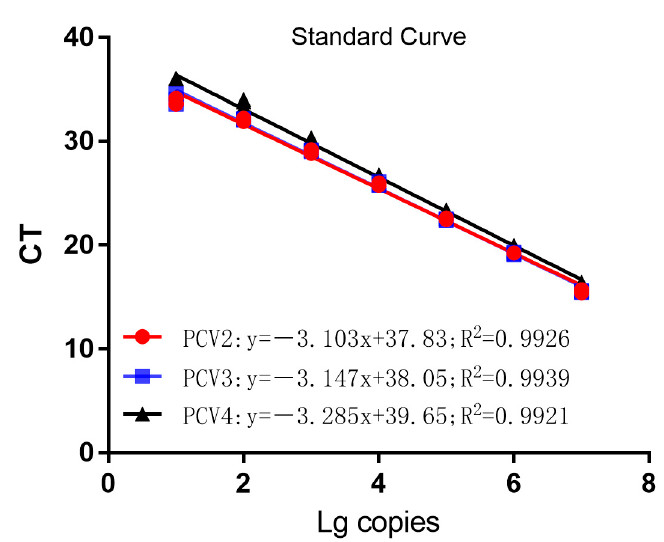
Figure 1. Standard curves of multiplex TaqMan qPCR.